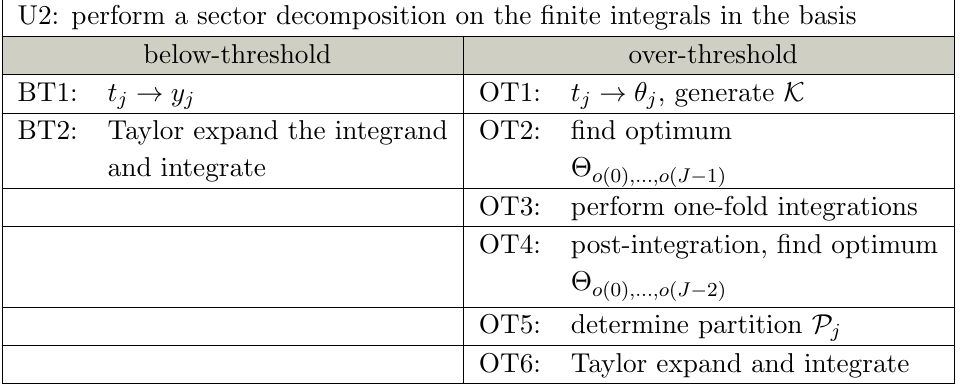
Table 1 . Summary of the individual steps of TayInt